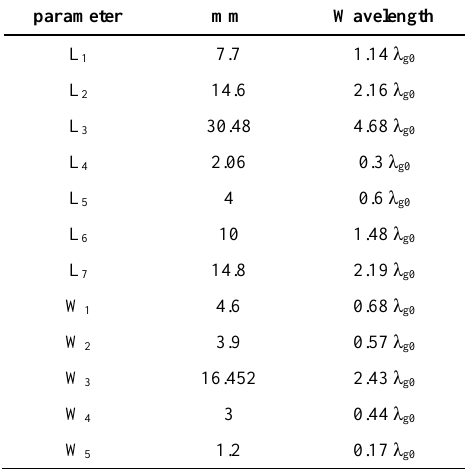
Table 1. The geometry of the prototype coupler.